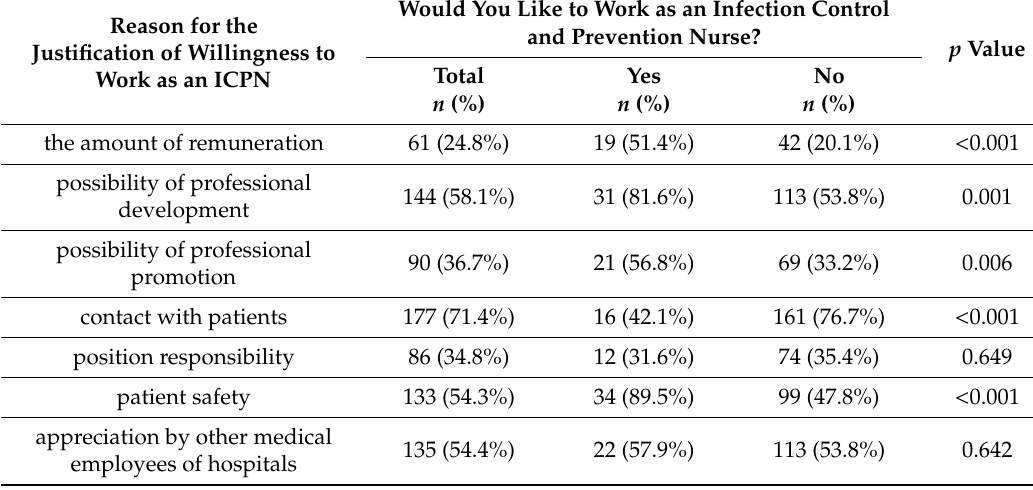
Table 4. Impact of the considered issues on the willingness to work as an infection control and prevention nurse.